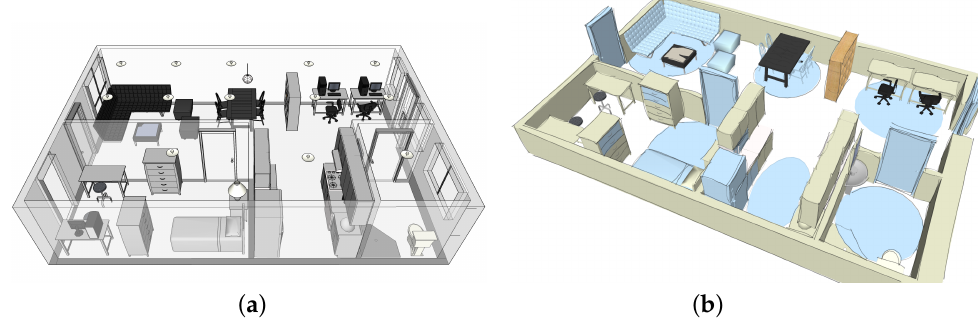
Figure 1. ( a ) The HINT layout. ( b ) The sensing capabilities of